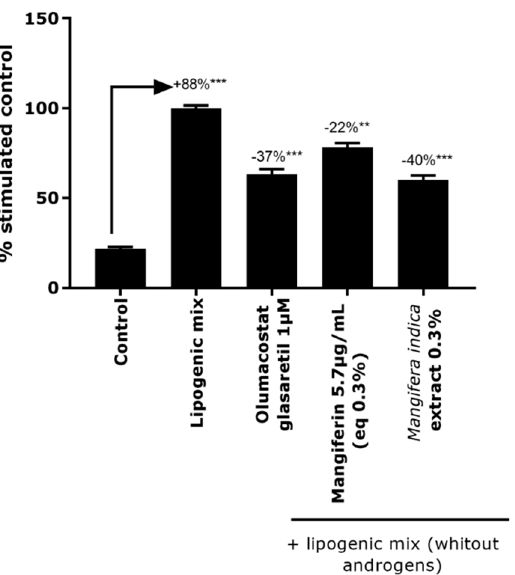
Figure 1. Lipid accumulation analysis measured by quantification of fluorescence intensity Bodipy ® . The results are expressed in percent of lipogenic mix condition. One-way ANOVA multiple comparisons test was used to determine the significance of the data with ** p < 0.01 and *** p < 0.001. 2.2. In Silico Studies: Comprehension of Mode of Action of the Three Main Phytochemical Compounds Found in Mangifera indica